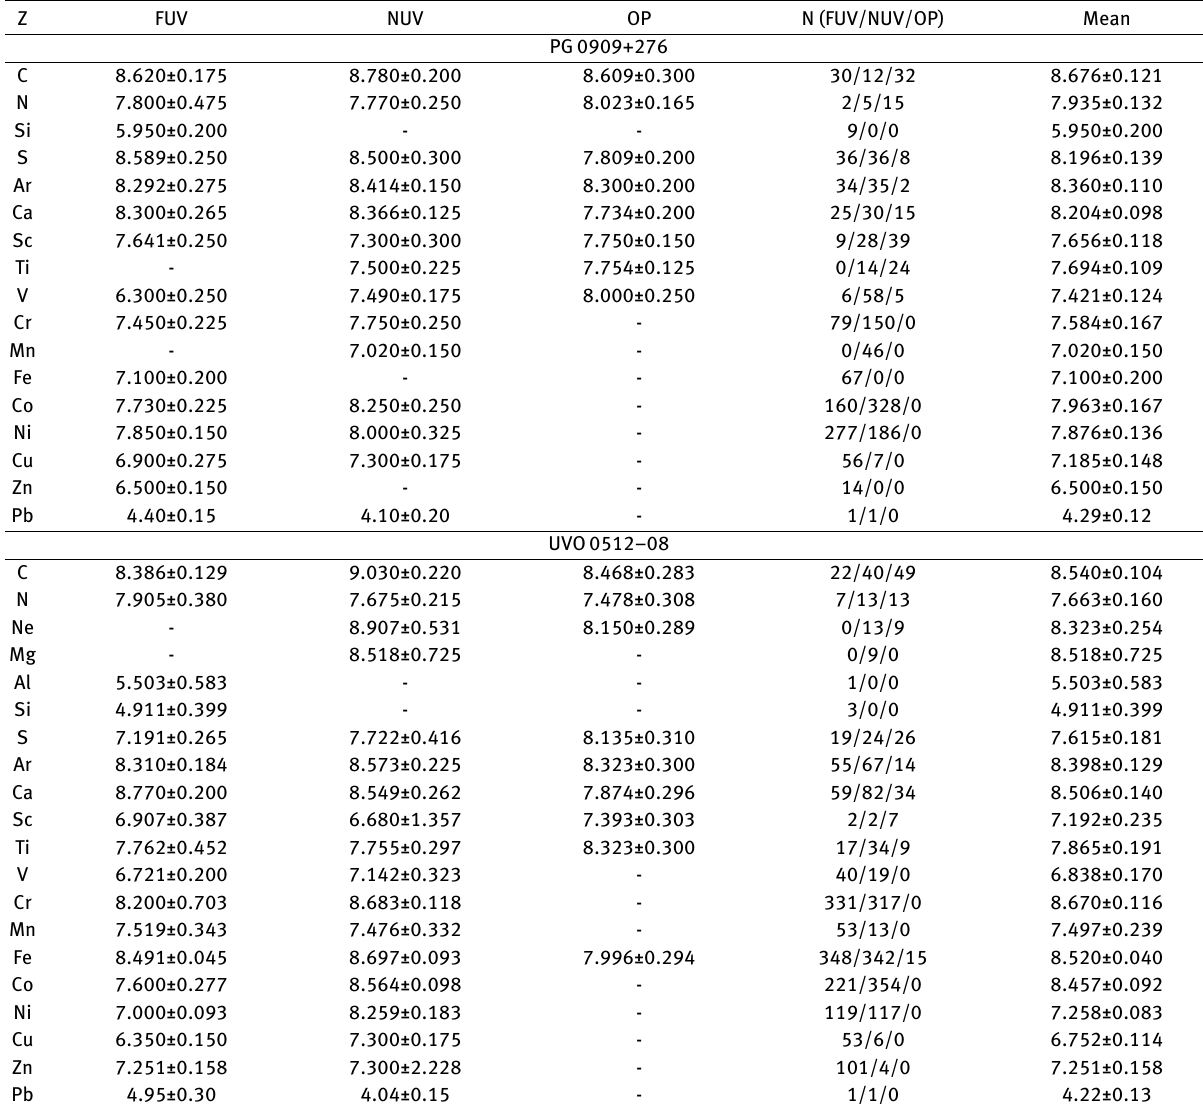
Table 3. Elemental abundance (log ϵ i ) by spectral region, the number of lines (N) contributing to each measurement and the mean weighted by the square of the